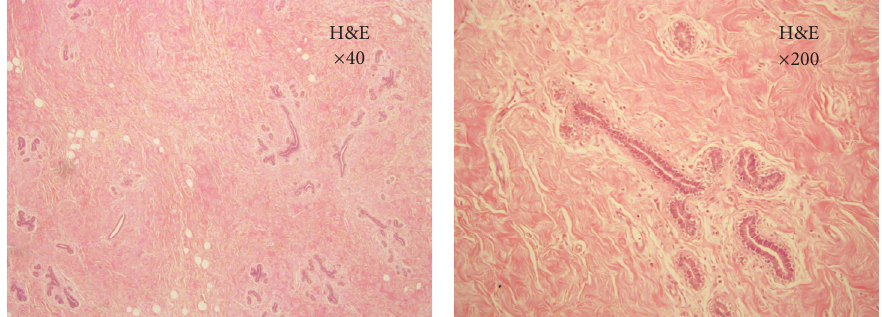
Figure 3: Histological appearance of the left breast in haematoxylin and eosin (H&E) stain. An increase in the interlobular stroma, composed of abundant collagen and fat, was seen. Duct was lined by the normal two-tier epithelium without atypia or hyperplasia. The right breast showed similar appearance.